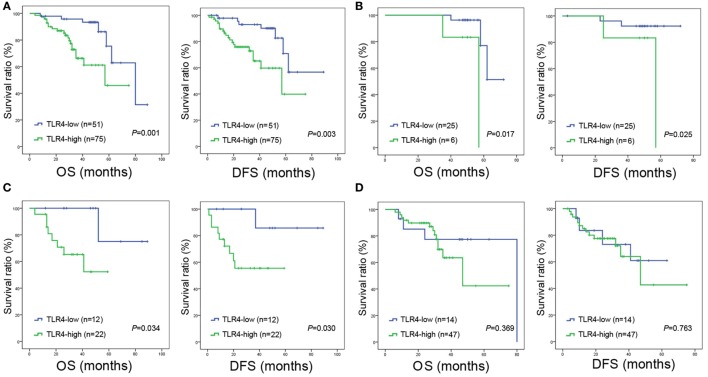
Overall survival (OS) and disease-free survival (DFS) curves of NSCLC patients according to cancer expressed toll-like receptor 4 (TLR4) levels. (A) All the enrolled patients with high expression of TLR4 were significantly associated with poor OS (P = 0.001) and DFS (P = 0.003). (B) Significantly poor OS (P = 0.017) and DFS (P = 0.025) in patients with TNM stage I and expressing high level of TLR4. (C) Significantly poor OS (P = 0.034) and DFS (P = 0.030) in patients with TNM stage II and expressing high level of TLR4. (D) For stage III, the difference of OS (P = 0.369) and DFS (P = 0.763) between TLR4 high expression group and TLR4 low expression group is not significant. In panels (A–D), OS and DFS were assessed by the Kaplan-Meier method and compared using log-rank test.